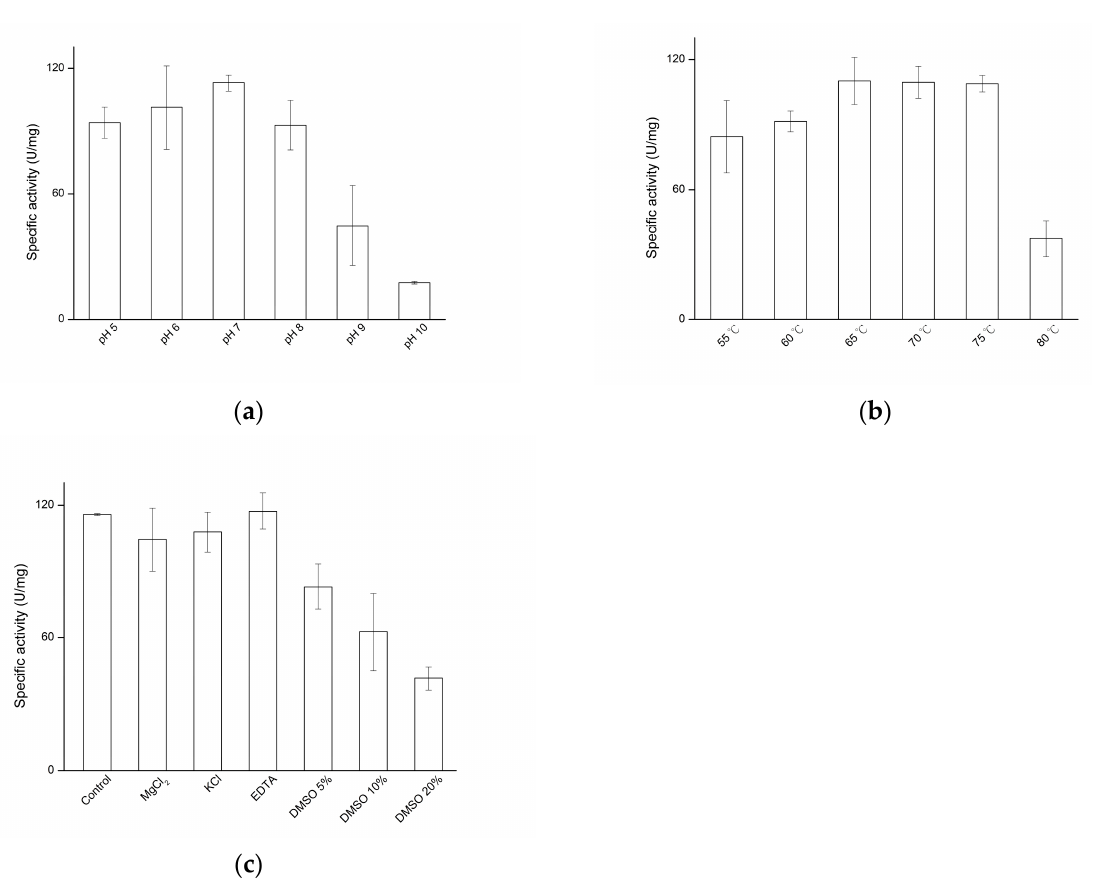
Figure 3. Effects of pH ( a ), temperature ( b ), and metal ion or dimethyl sulfoxide (DMSO) ( c ) on the hydrolytic activity of Pg MA. The reaction was performed with 1% ( w / v ) β -cyclodextrin (CD), 5.6 μ g/mL of Pg MA, and 50 mM of a different buffer at the tested temperature in the absence or presence of the tested metal ion or DMSO for 30 min. After the reaction was stopped by boiling, the hydrolytic activity of Pg MA was determined by measuring the reducing sugars produced from the reaction as described in Section 2.